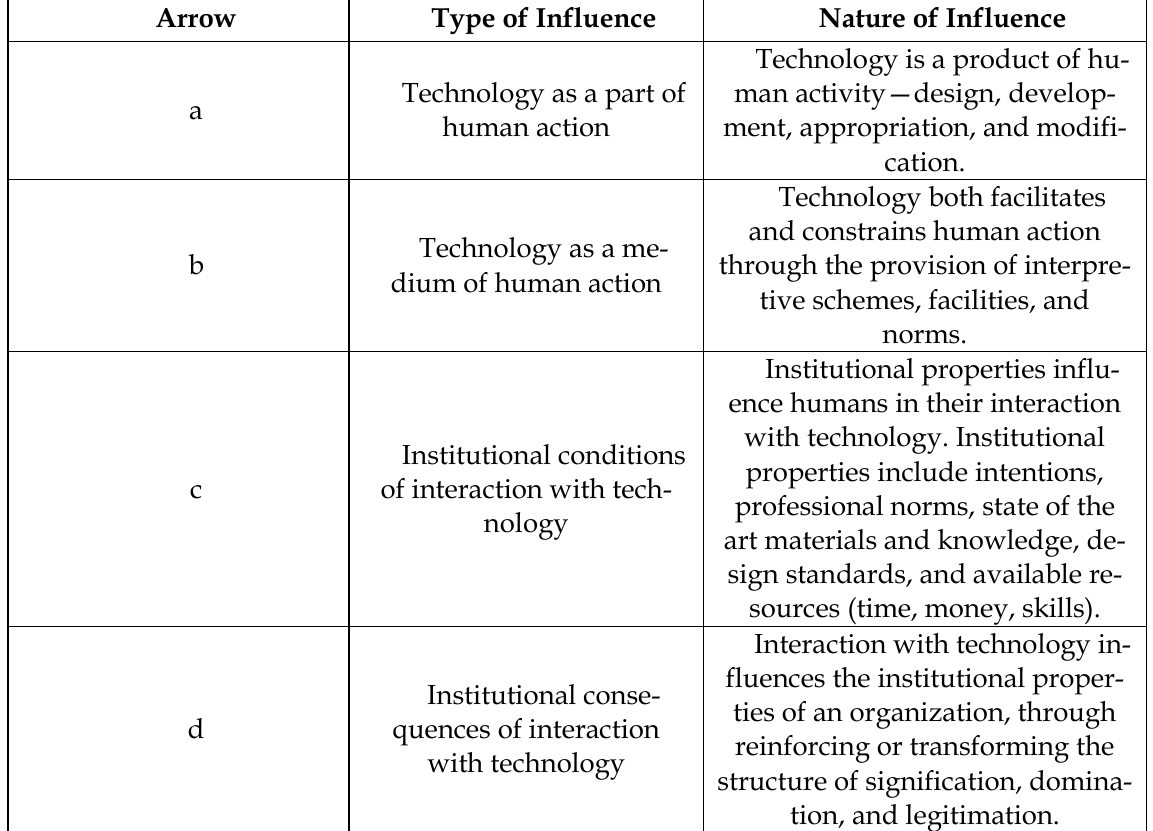
Table 2: Structurational Model of Technology Relationships (Orlikowski, 1992, p. 410) Arrow Type of